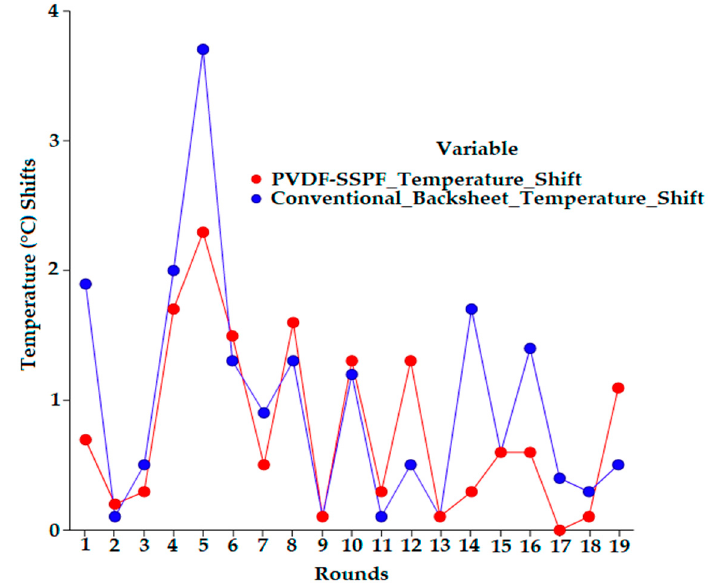
Figure 7. Temperature shifts of PVDF-SSPF and conventional backsheets.